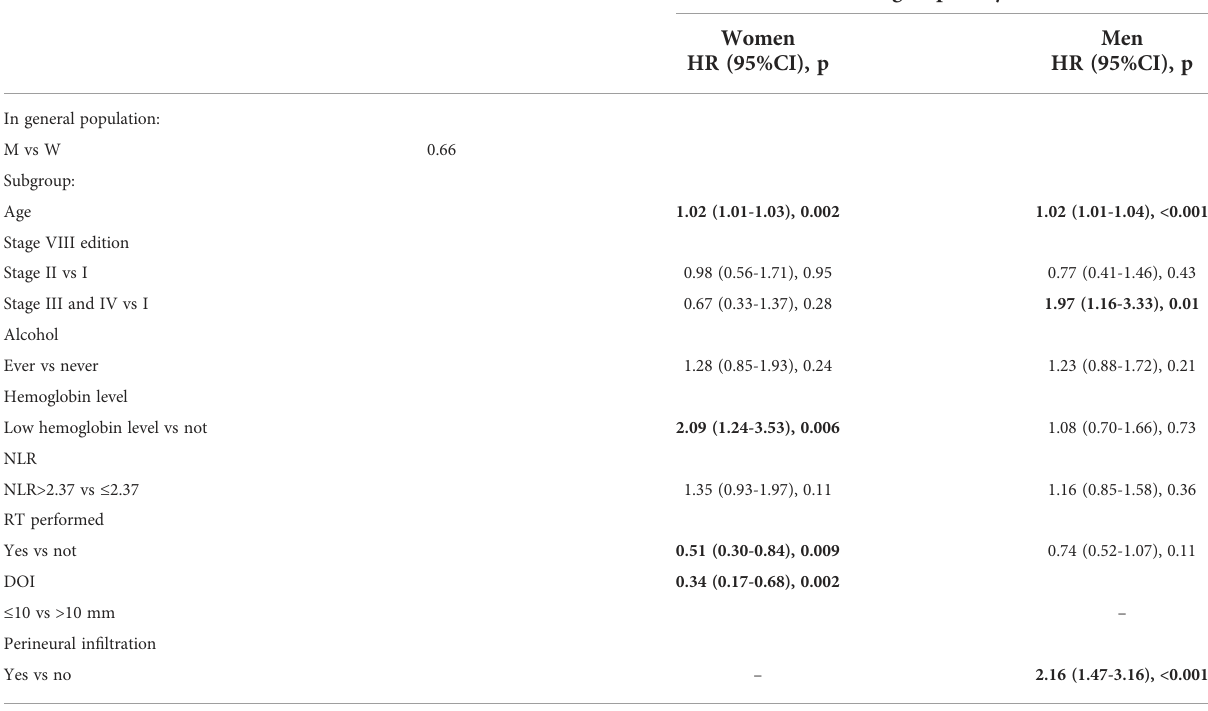
TABLE 3 Disease Free Survival (DFS) for 576 patients, multivariate analysis.